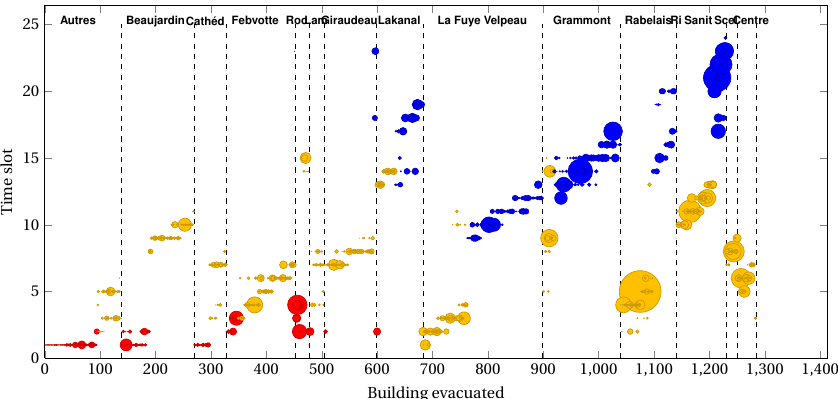
Figure 13. Representation of the evacuation of neighborhoods of the city of Tours based on their exposures. Each building ( x axis) is represented by a circle where its size indicates the number of vehicles evacuated from this building. Each color represents an exposure level ([0, 300]; [300, 900]; [900, +